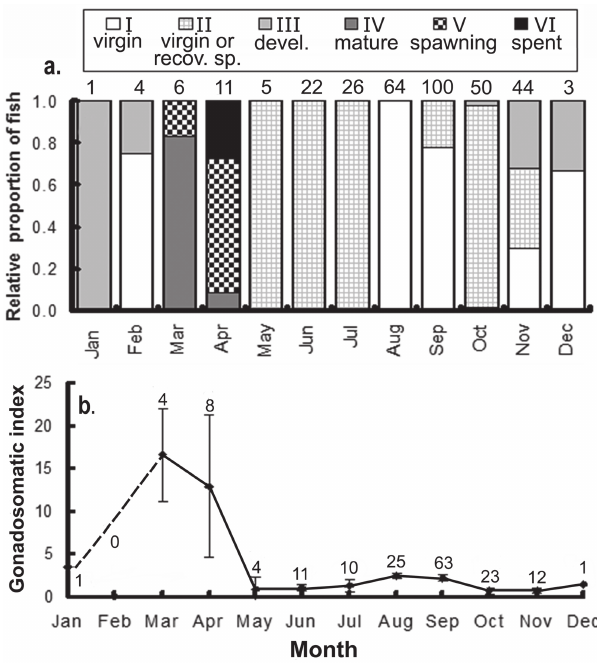
Fig. 3. Monthly gonad condition of Prochilodus nigricans in 1999. a. Percentage of males and females in six different gonad development stages (sample sizes are above bars). b. Monthly mean gonadosomatic indices (GSI) for females; vertical bars are 95% confidence intervals (sample sizes are above bars). recov. Sp. = ?, devel.